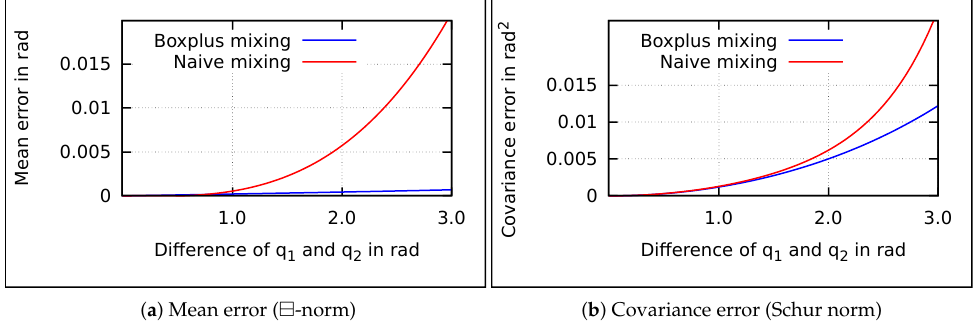
Figure 4. Mean and covariance error of (cid:1) - and naive-mixing compared to optimal mixing over the angular differences of q 1 and q 2 . Reprinted with permission from ref. [22]. Copyright 2020